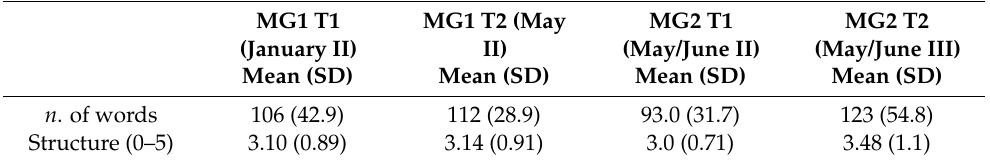
Table 3. Narrative skills measures obtained in the groups MG1 and MG2 at the respective times of detection.